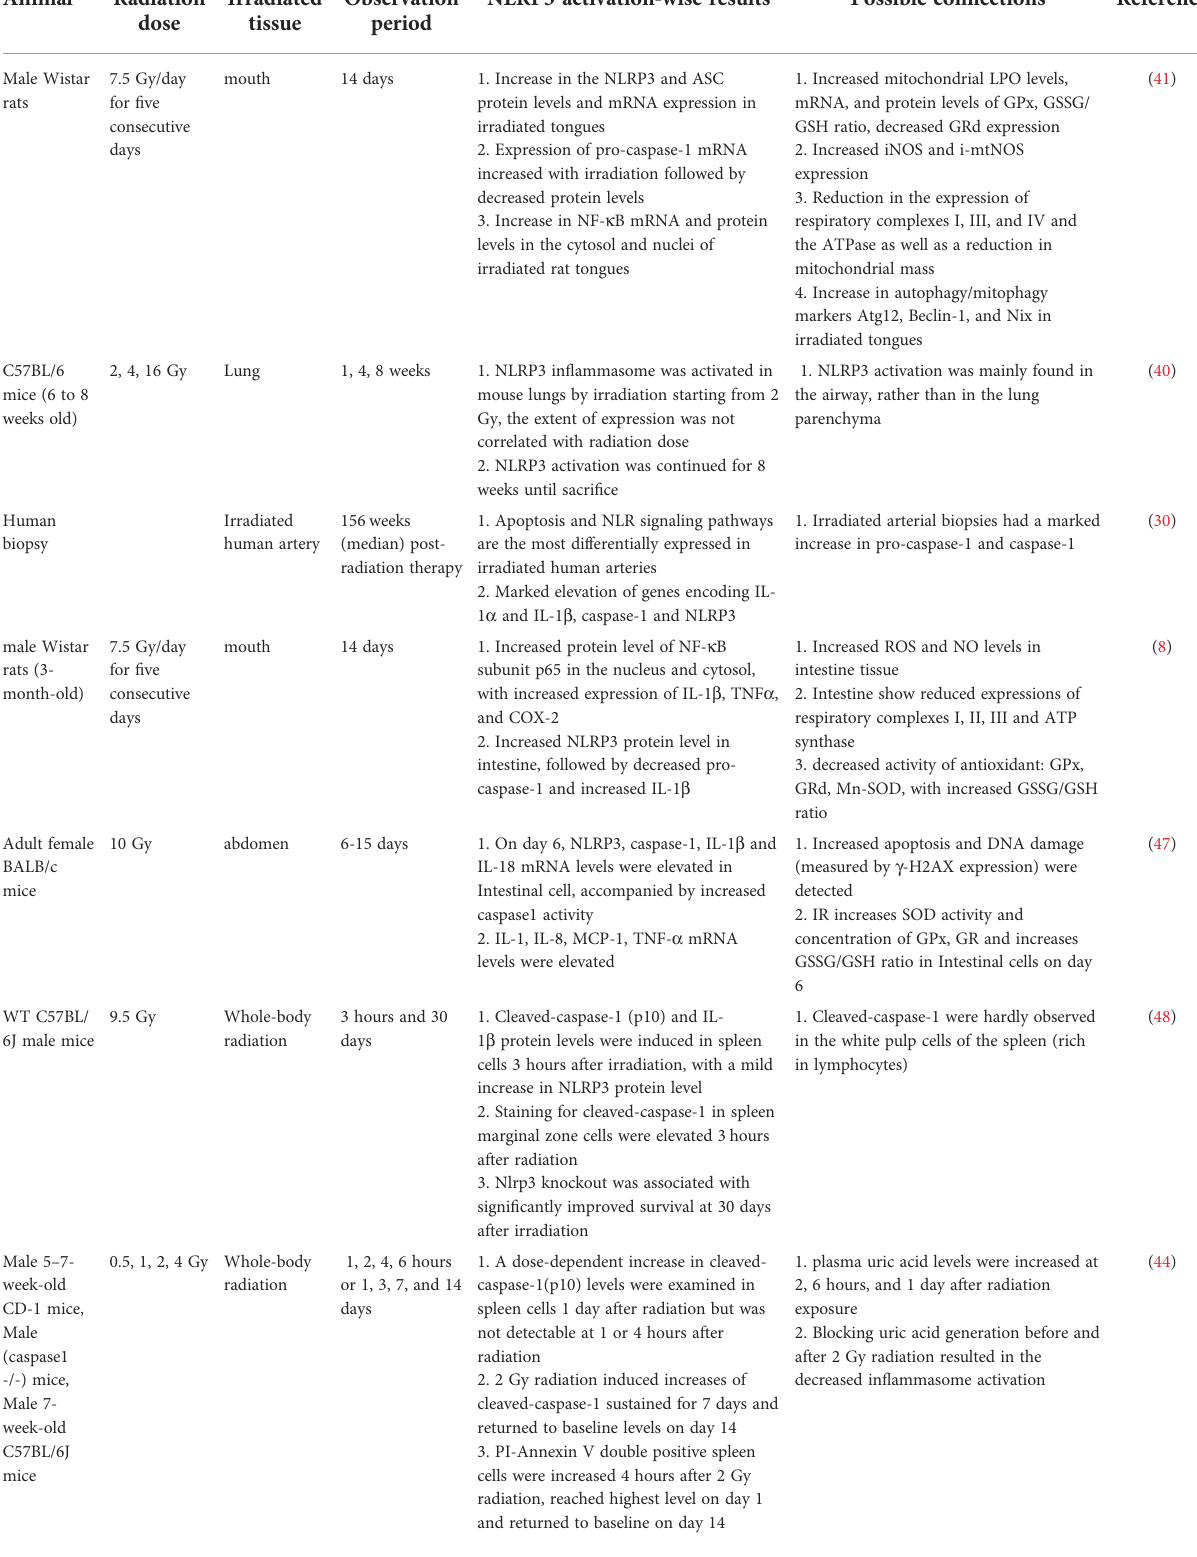
TABLE 1 In vivo studies involving radiation-induced NLRP3 in fl ammasome